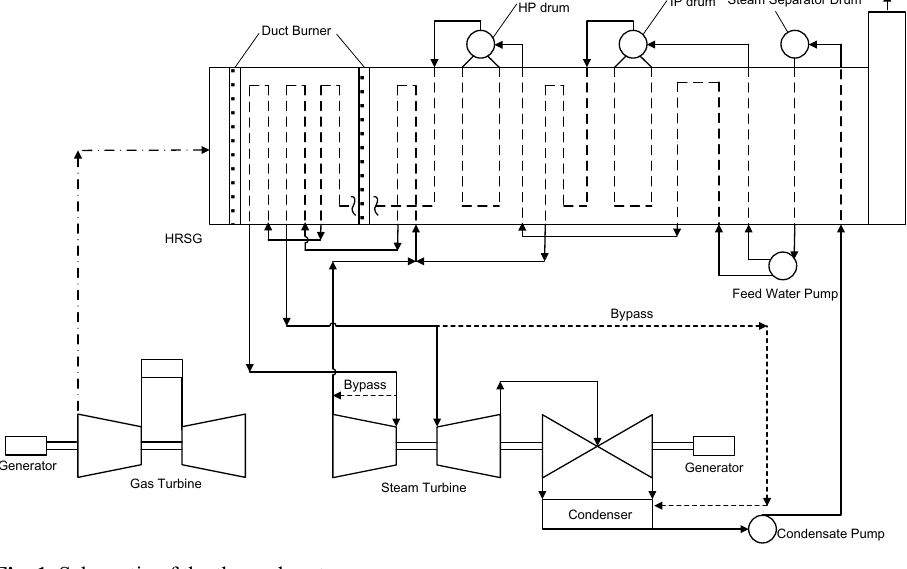
Fig. 1. Schematic of the thermal system. Table 1. Initial conditions of HP and IP